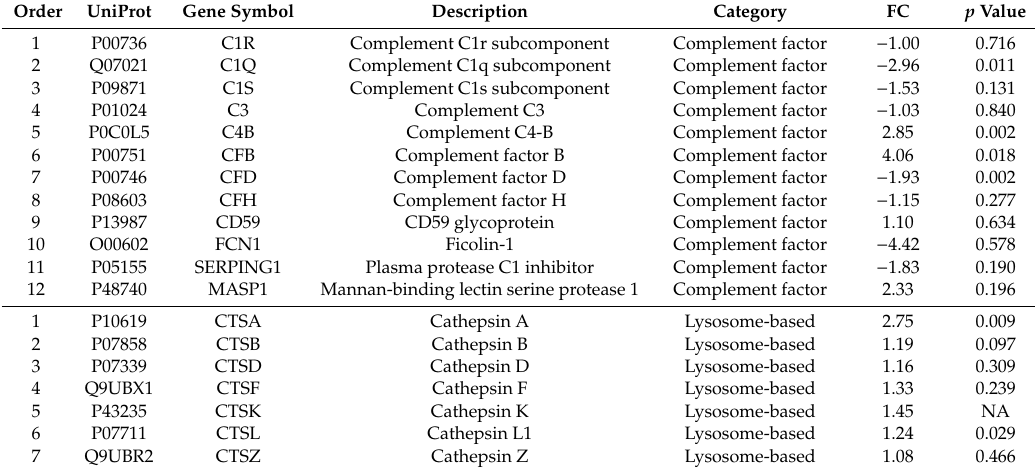
Table 4. Complement factors and